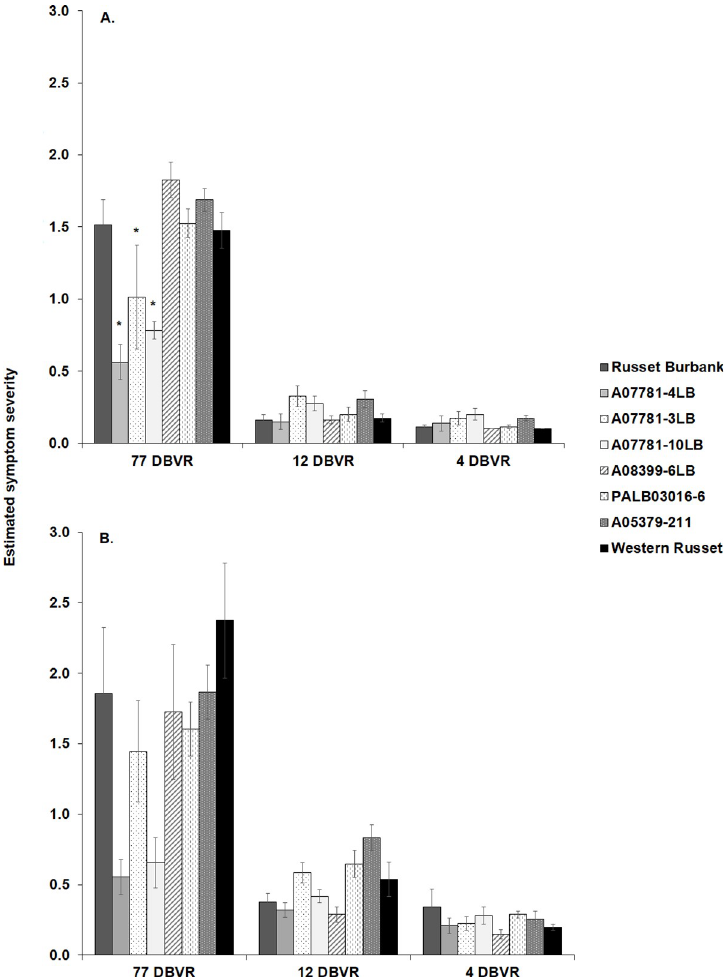
Fig 3. ZC symptoms severity in potato genotypes infested at either 77, 12 or 4 DBVR. Evaluations were conducted in tubers at harvest in (A) 2016 and (B) 2017. Significant differences in ZC symptom severity scores among genotypes in each time of infestation are indicated by asterisks. The severity of ZC symptoms in A07781-3LB, A07781-4LB, and A07781-10LB were significantly lower than other genotypes at 77 DBVR in 2016. Statistical analysis was performed on log-transformed data. Error bars represent standard error ( ±